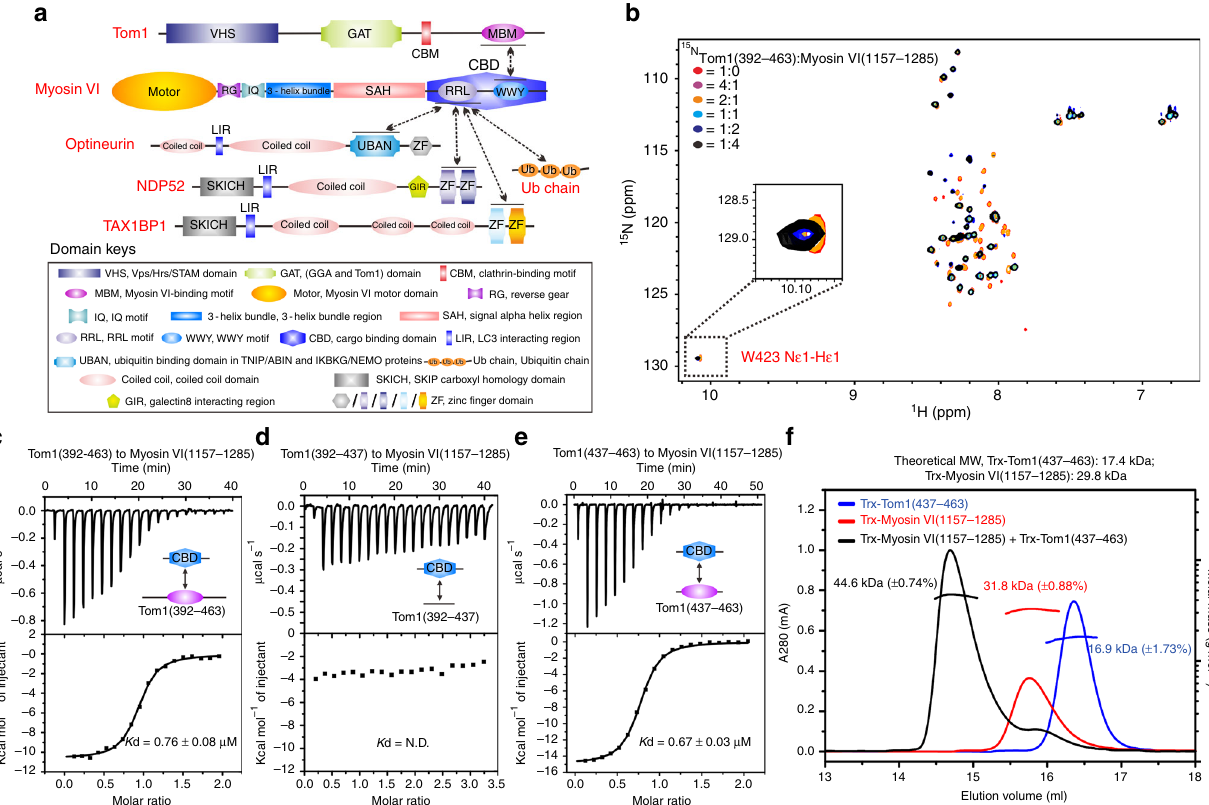
Fig. 1 Biochemical analyses of the interaction between Myosin VI and Tom1. a A schematic diagram showing the domain arrangements of Myosin VI, Tom1, NDP52, TAX1BP1, and Optineurin. In this drawing, domains involved in the protein – protein interaction are highlighted with black lines, and the relevant interactions between two proteins are indicated by two-way arrows. b Superposition plots of the 1 H- 15 N HSQC spectra of Tom1(392 – 463) titrated with the un-labeled C-terminal CBD of Myosin VI proteins at different molar ratios. For clarity, the insert shows the enlarged view of a unique peak corresponding to the side chain of Tom1 W423 residue in the overlaid 1 H- 15 N HSQC spectra. c – e ITC-based measurements of the binding af fi nities of the C-terminal CBD of Myosin VI with Tom1(392 – 463) ( c ), Tom1(392 – 437) ( d ), and Tom1(437 – 463) ( e ). Kd values are the fi tted dissociation constants with standard errors, when using the one-site binding model to fi t the ITC data. ‘ N.D. ’ stands for that the Kd value is not detectable. Source data are provided as a Source Data fi le. f Overlay plots of the multi-angle light-scattering data of the C-terminal CBD of Myosin VI, Tom1(437 – 463), and the C-terminal CBD of Myosin VI in complex with Tom1(437 – 463). The derived molecular masses of the C-terminal CBD of Myosin VI and Tom1(437 – 463) are shown in red and in blue, respectively, while the derived molecular mass of the C-terminal CBD of Myosin VI and Tom1(437 – 463) complex is shown in black. The molecular masses errors are the fi tted errors obtained from the data analysis software, and are showed in the brackets. The results clearly demonstrate that the C-terminal CBD of Myosin VI and Tom1(437 – 463) both form a stable monomer and may interact with each other to form a 1:1 stoichiometric complex in solution. Source data are provided as a Source Data fi